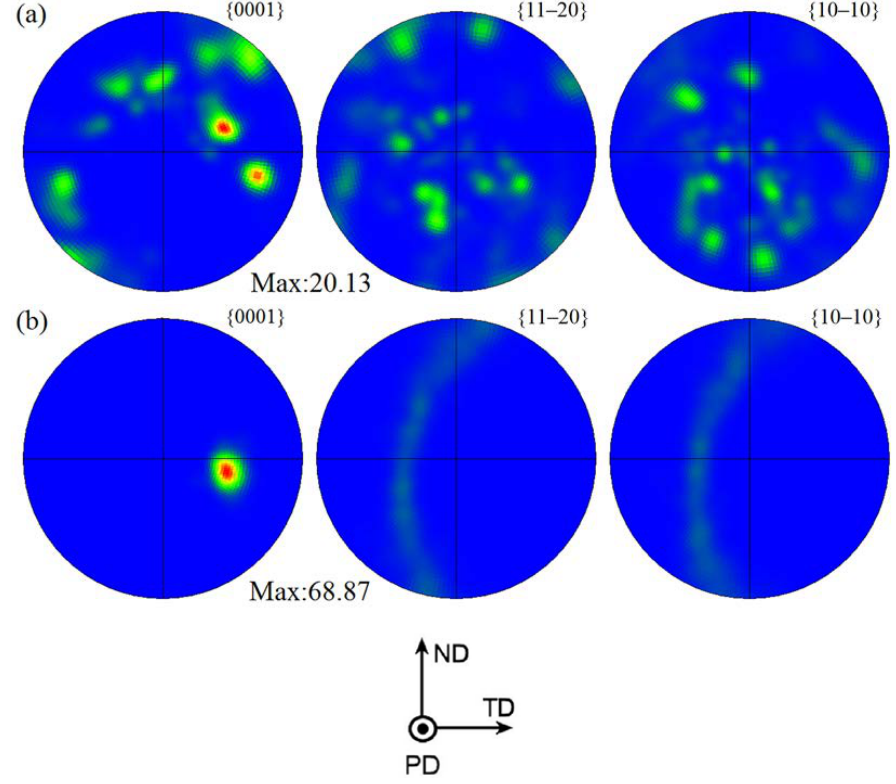
Figure 10. Pole figures of the thermo-mechanically affected zone (TMAZ) and SZ in region A of the